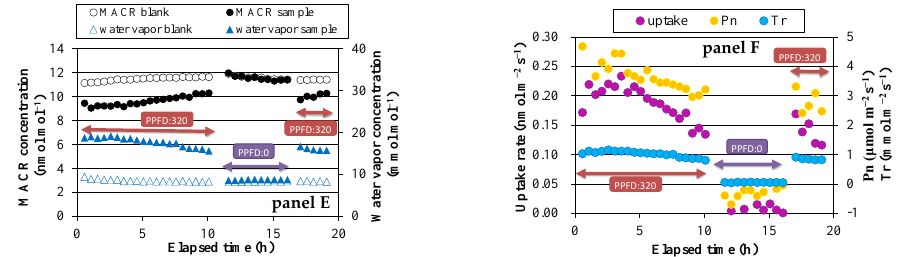
Figure 1. Time course of volatile organic compounds (VOCs) and water vapor concentrations, exchange rates of VOCs, net photosynthetic rate (P n ), and transpiration rate (Tr). Panels A and B: methyl vinyl ketone (MVK) fumigation experiment using Spathiphyllum clevelandii ; panels C and D: MVK fumigation experiment using Quercus acutissima ; panels E and F: methacrolein (MACR) fumigation experiments using Quercus myrsinifolia .